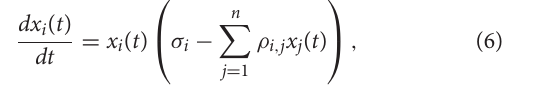
T surrogates. (B) Examples of the RP (top) and ·